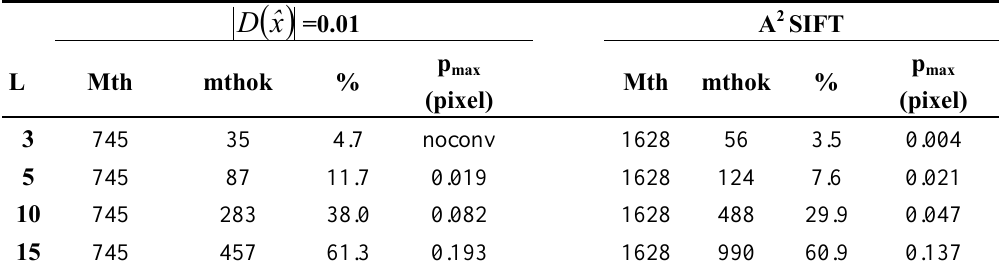
Table 7. Villareggia Test 2. Experimental results of the SIFT operator, in relation to   xˆD , L